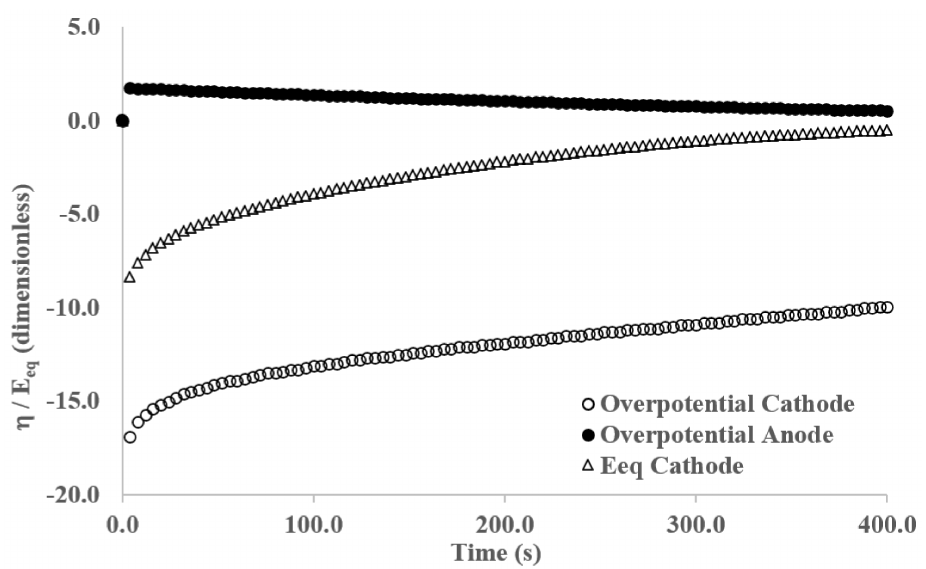
Figure 5. Calculated overpotential and equilibrium potential values at the cathode and anode half-cells.